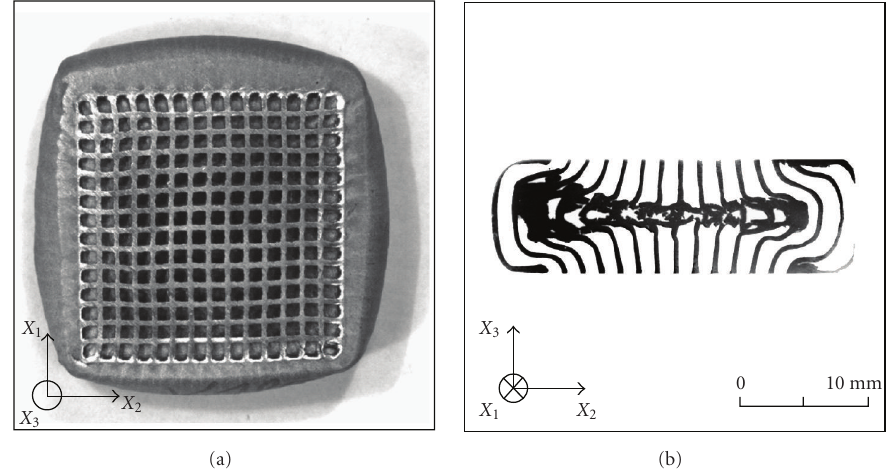
Figure 4: Macrostructure of the TRIP-MC honeycomb specimen with 2.5 vol.% zirconia after approximately 60% compressive strain, (a) top view, (b) cross-section after preparation ( X 3 -axis indicates out-of-plane loading).